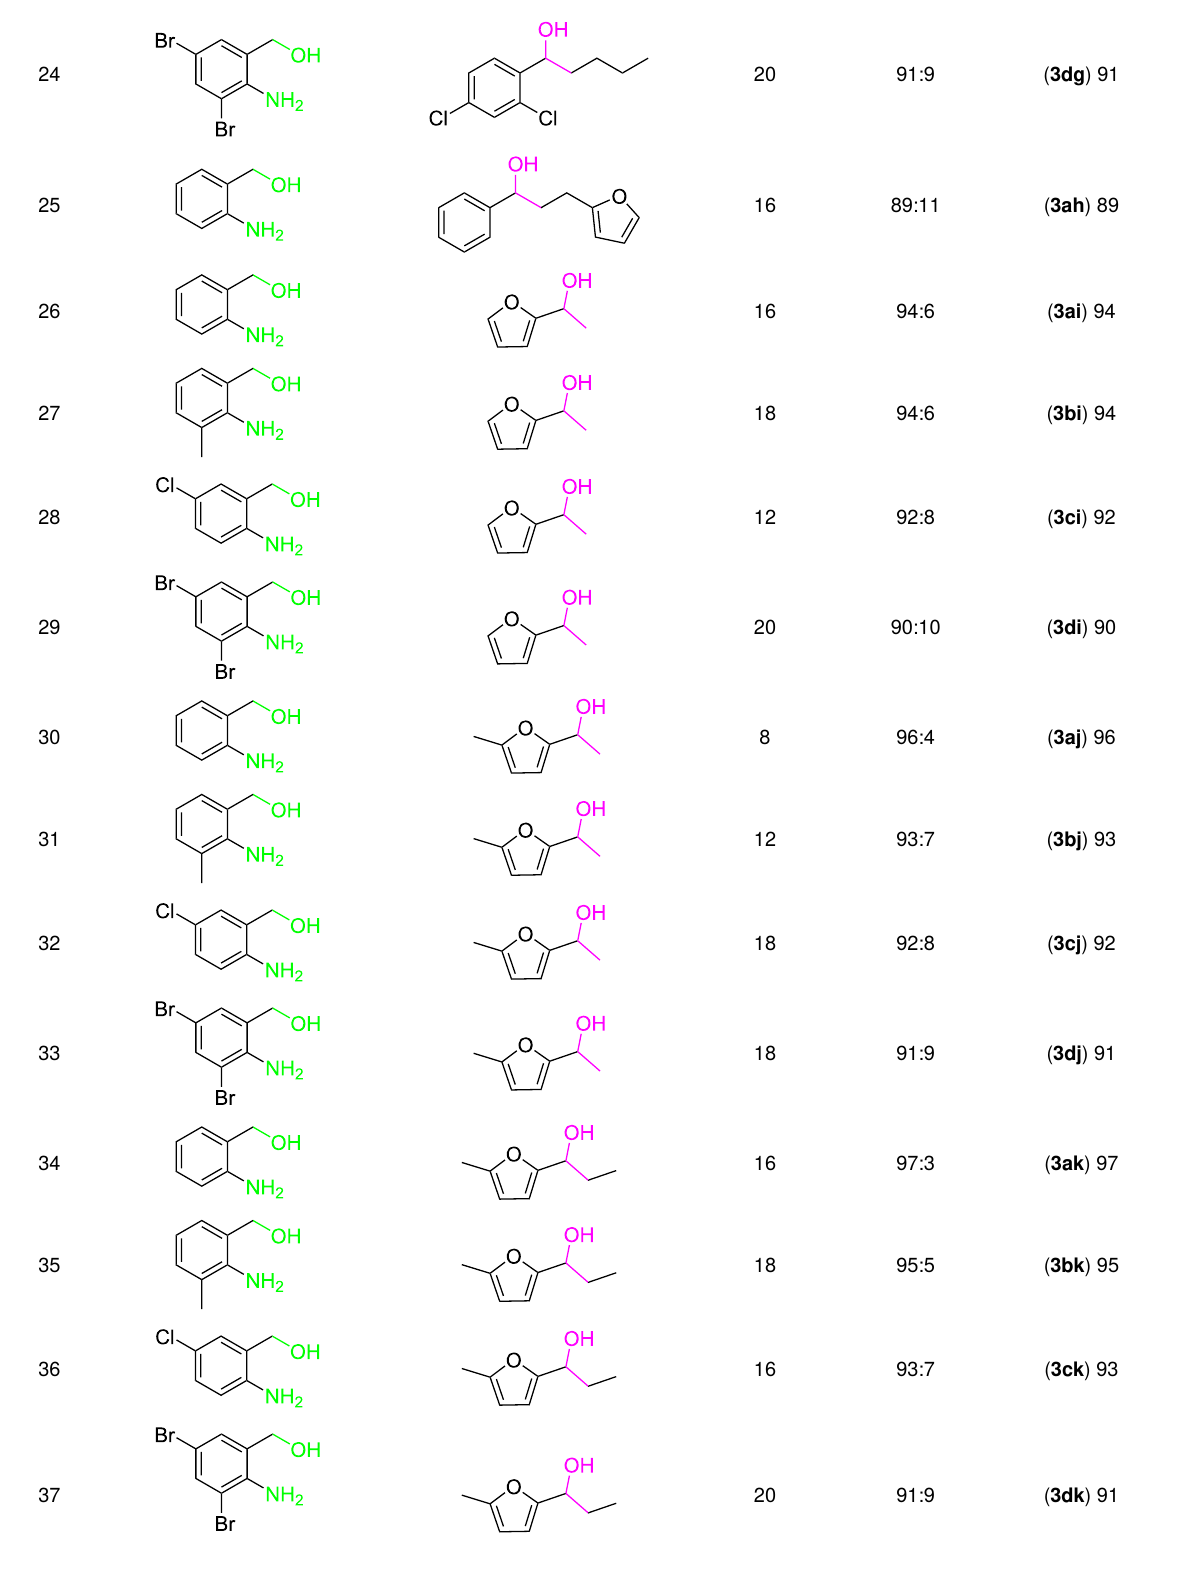
Table 3: Cyclometalated iridium-catalyzed ADC reaction of various 2-aminobenzyl alcohols and secondary alcohols. a